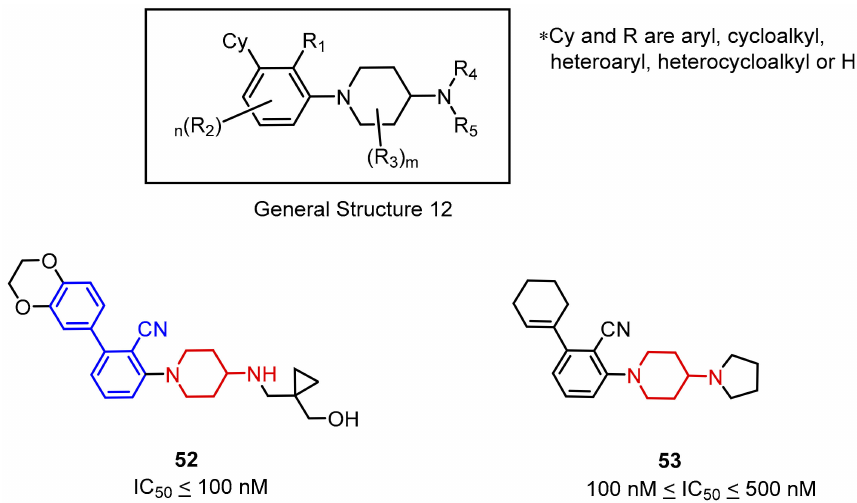
Figure 22. General structure and examples of the PD-1 / PD-L1 inhibitors ( 50 and 51 ) reported by Incyte Corporation [71].